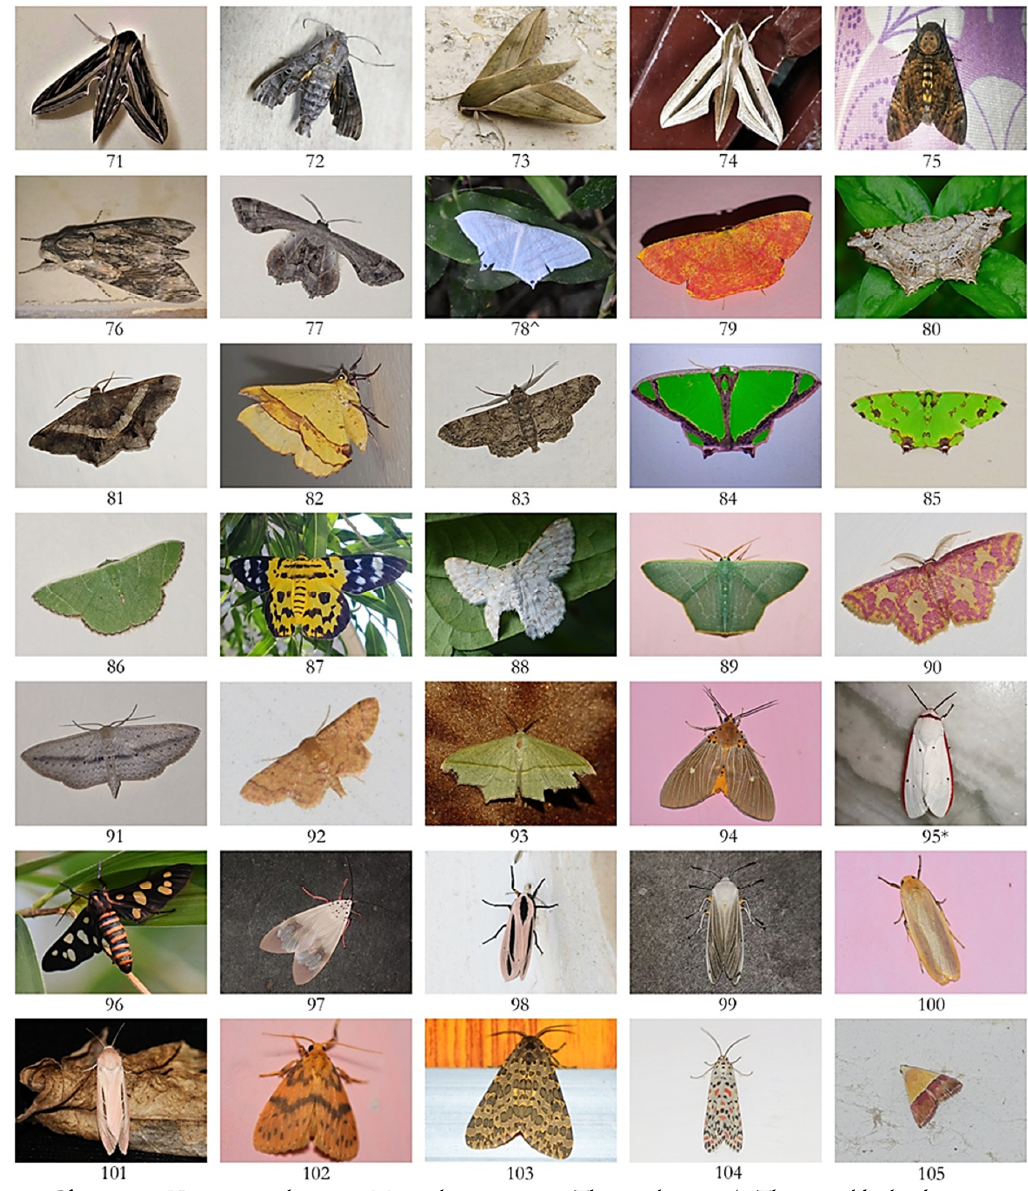
Plate 3. 71- Hippotion celerio; 72- Macroglossum sp.; 73- Theretra lucasii; 74- Theretra oldenlandiae;